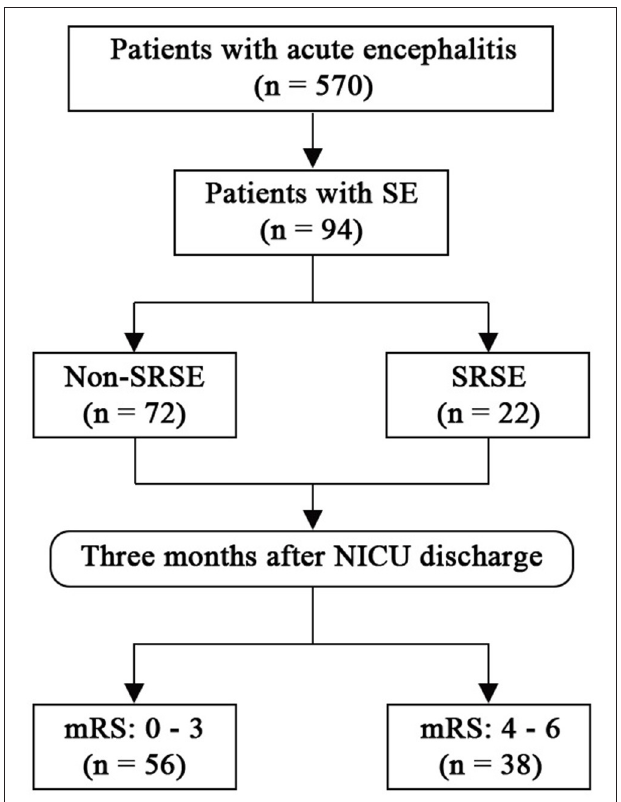
FIGURE 1 | Flow chart. mRS, modified Rankin Scale; SE, status epilepticus; SRSE, super-refractory status epilepticus.